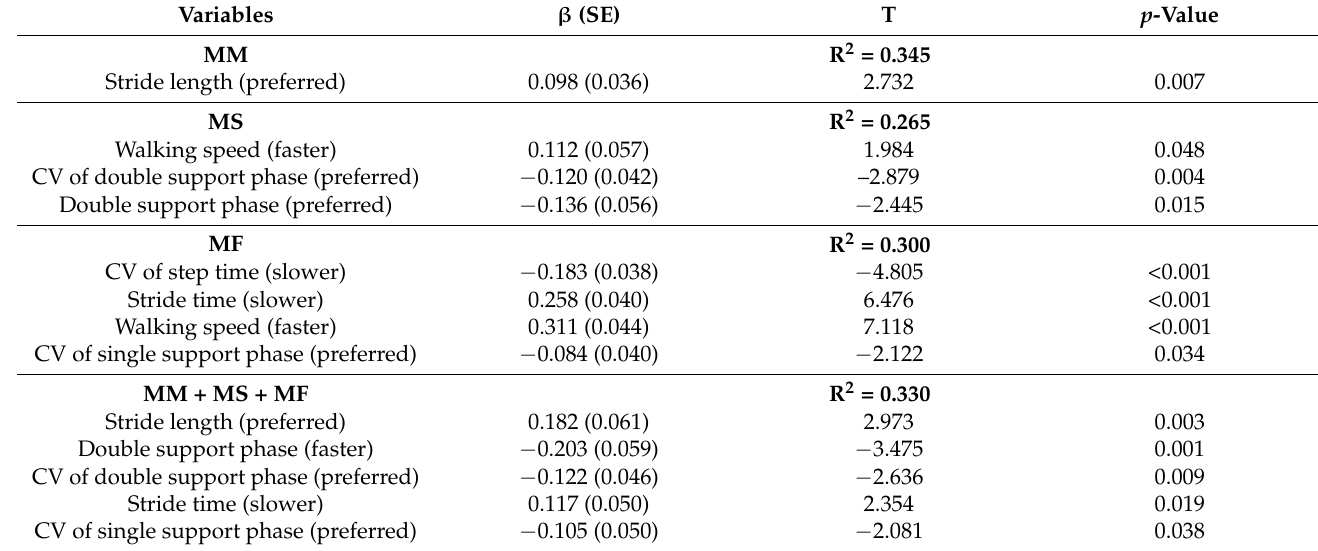
Table 2. Association of the gait variables at three different speeds with MM, MS, and MF-related variables.